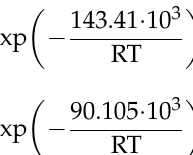
Figure 7. Plots of LnK against 10,000/T; without additives ( a ) and with 13.65% Na 2 SO 4 ( b ).